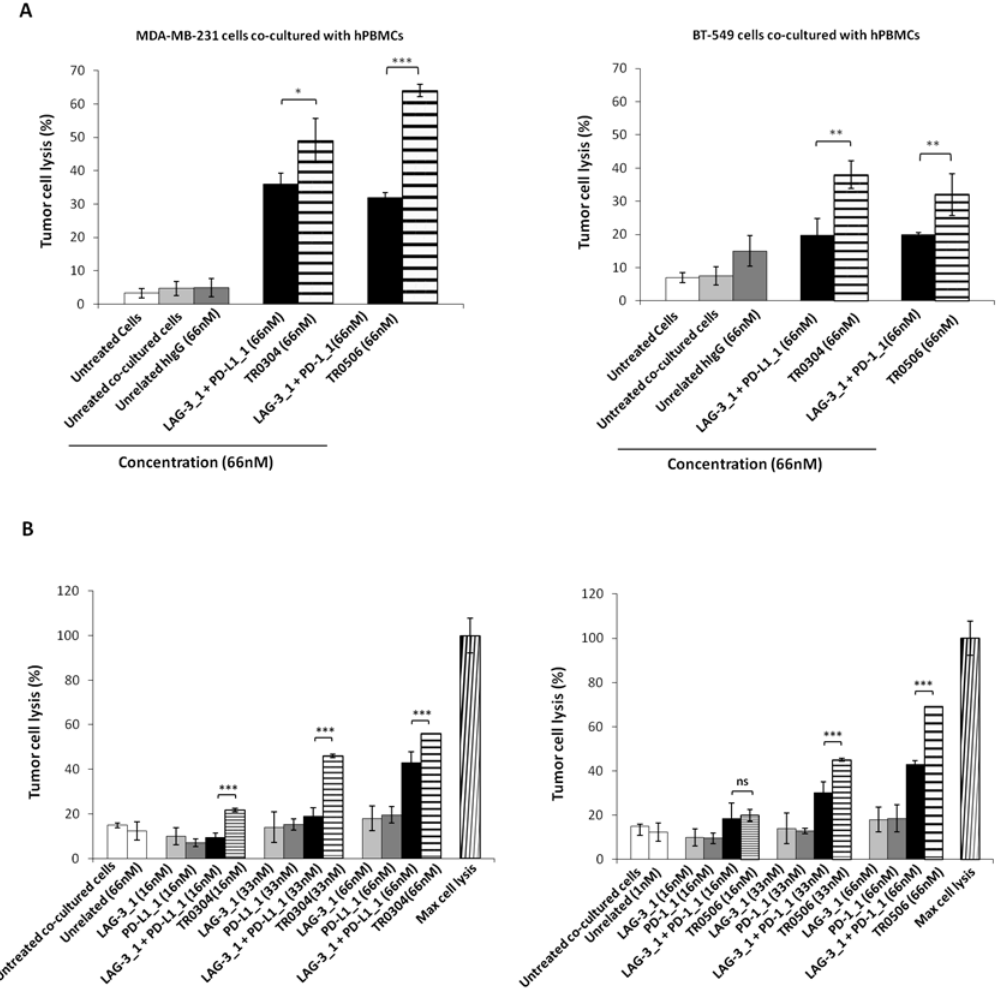
Figure 8. Cytotoxic effects of tribodies or their parental mAbs on breast tumor cells co-cultured with human lymphocytes. ( A ) Tumor cells lysis was evaluated by measuring the levels of LDH released in the supernatants of MDA-MB-231 (left panel), or BT-549 (right panel) cells cocultured with hPBMCs (6:1 Effector:Target ratio), treated as indicated for 48 h. ( B ) MDA-MB-231 cells co-cultured with hPBMCs (6:1 E:T ratio) were treated with the TR0304 and TR0506 tribodies or the corresponding parental mAbs at increasing concentrations for 48 h, and the levels of LDH in the supernatants were measured and expressed as % of maximum cell lysis. Maximum cell lysis was obtained by adding 0.9% Triton X-100 (Thermo Fisher Scientific, Darmstadt, Germany). Error bars depict means ± SD. p -value: *** p ≤ 0.001; ** p < 0.01; * p < 0.05.